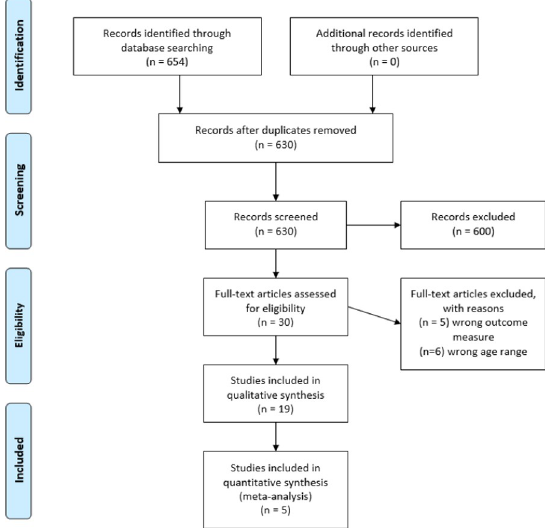
Fig 2. Risk of bias assessments of randomized trials included in the